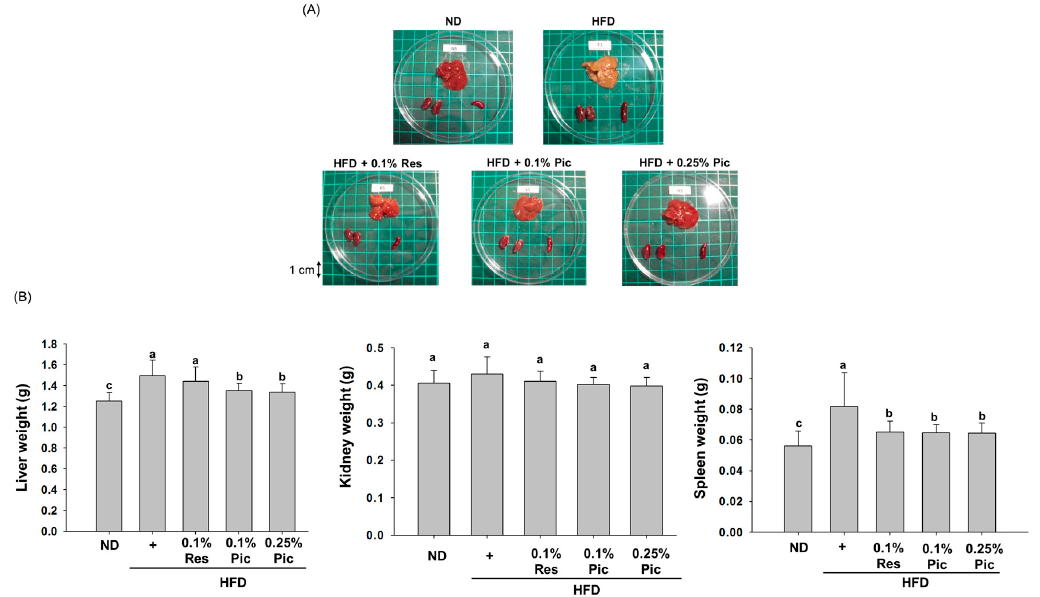
Figure 5. Effect of piceatannol supplementation on organ weight in HFD-fed C57BL/6 mice. ( A ) Morphology of the organs; ( B ) Weights of the liver, kidney and spleen. Data are expressed as the means ± SE ( n = 8 per group). The values with different letters are significantly different ( p < 0.05) as determined by Duncan’s multiple range test.